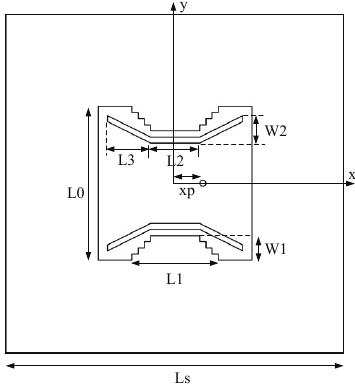
Figure 20. Improved antenna